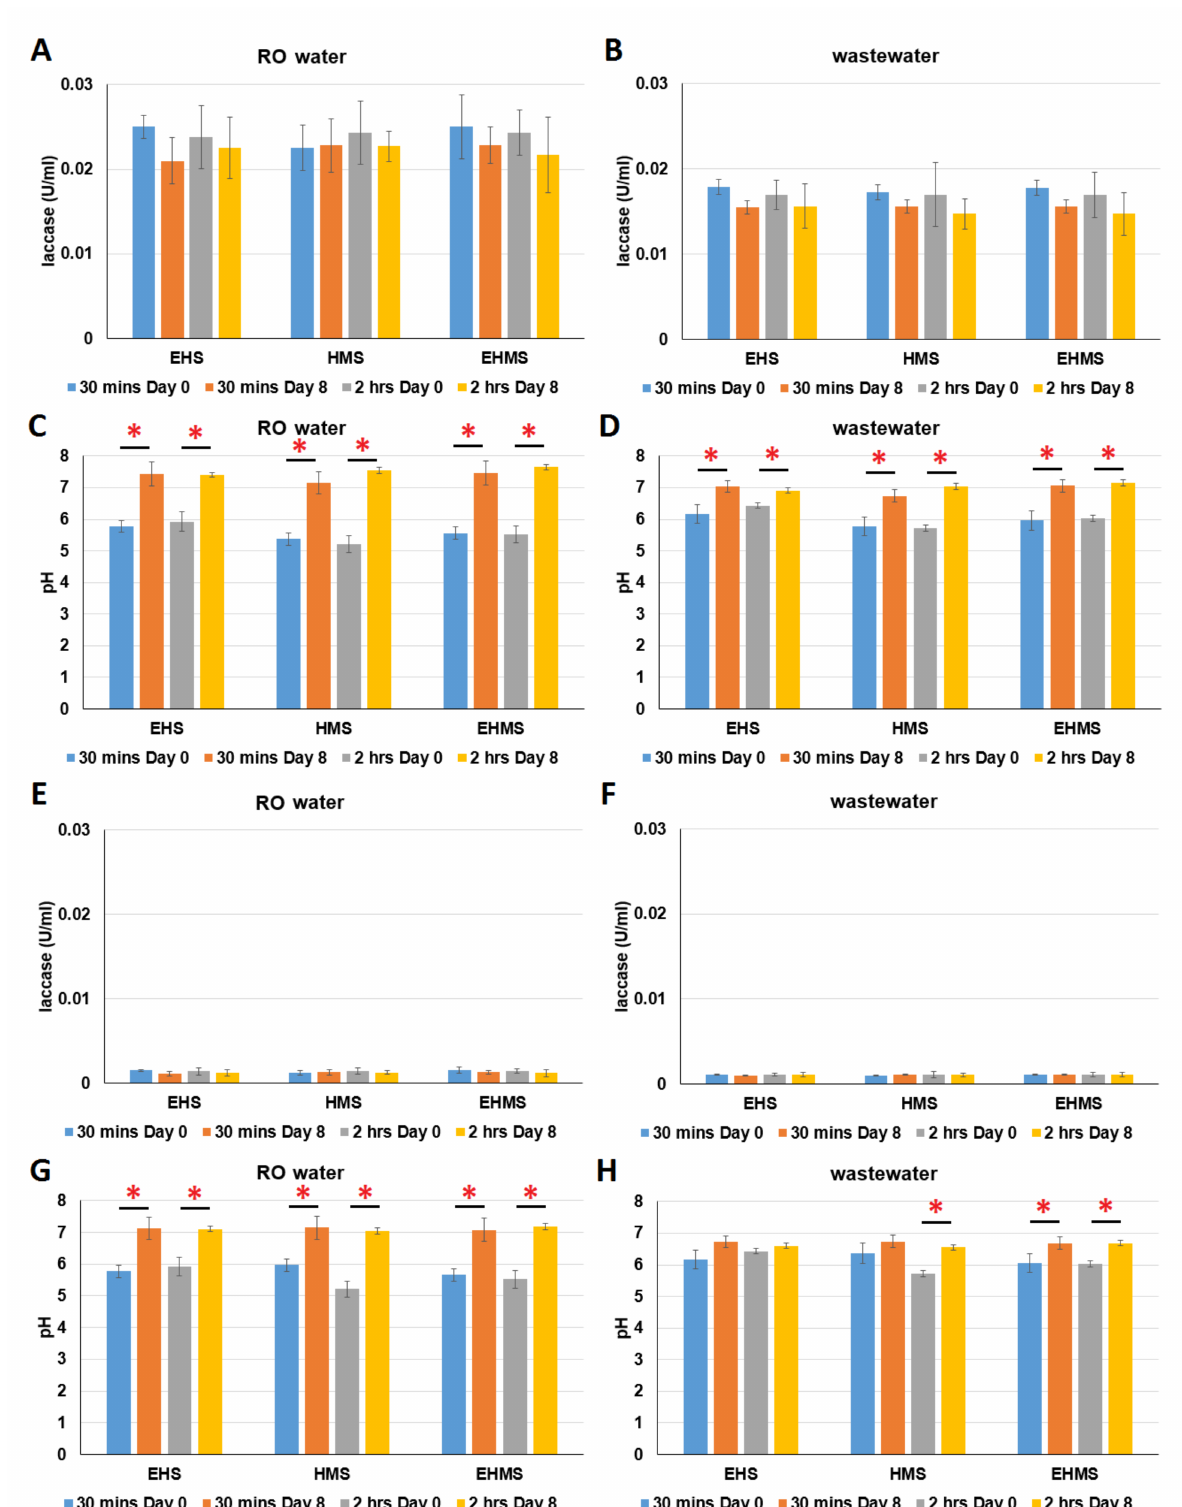
Figure 10. Laccase activity and pH values of the enzyme extracts before (Day 0) and after (Day 8) the bioreactor experiments. Bioreactor experiments simulating UV filter removal in reverse osmosis (RO) filtration water and wastewater using the spent mushroom compost of two mushrooms ( Pleurotus ostreatus ( A – D ) and Auricularia polytricha ( E – H )). Data from triplicate experiments are presented as the mean ± SE. EHMC: ethylhexyl methoxycinnamate, EHS: 2-ethylhexyl salicylate, HMS: homosalate. Red stars indicate the p values of t tests <